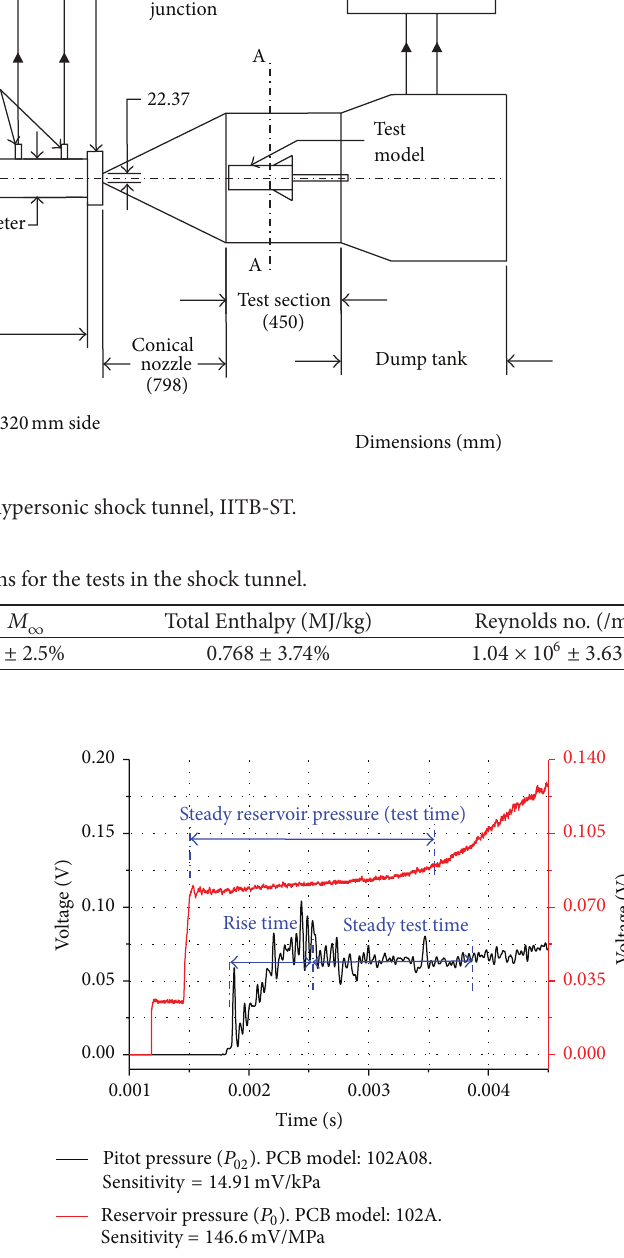
Figure 2: Representative pressure traces of the reservoir ( 𝑃 0 , inlet of nozzle) and Pitot tube ( 𝑃 02 , exit of nozzle) in the shock tunnel.